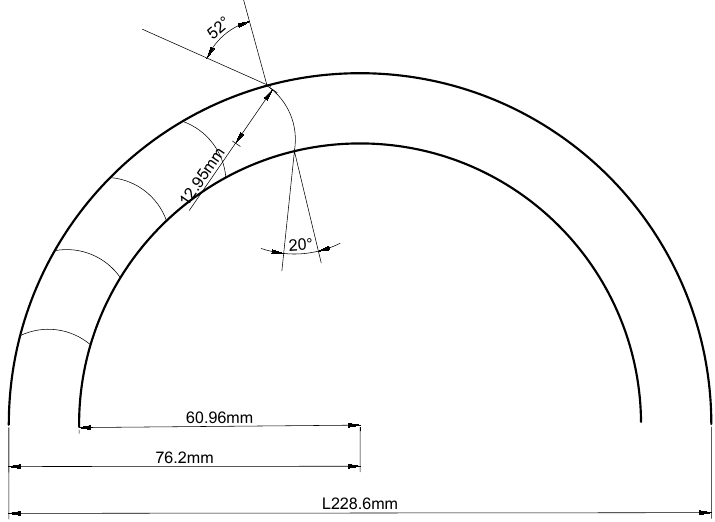
Figure 3. Eck/Laing CFF rotor